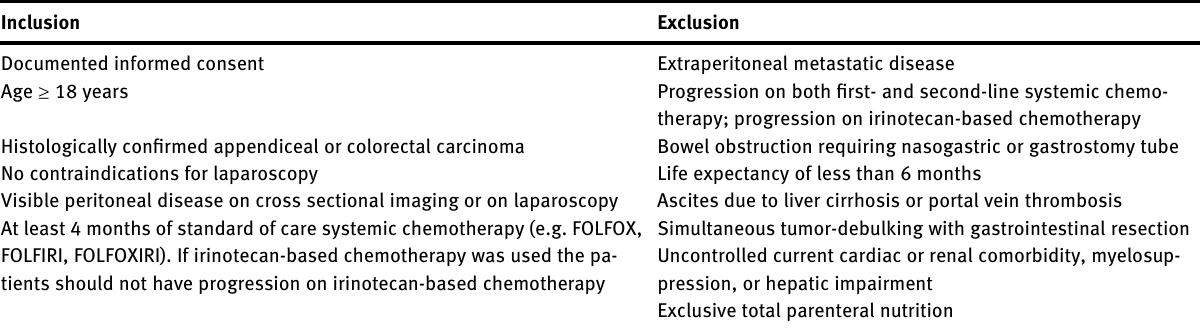
Table  : Inclusion and exclusion